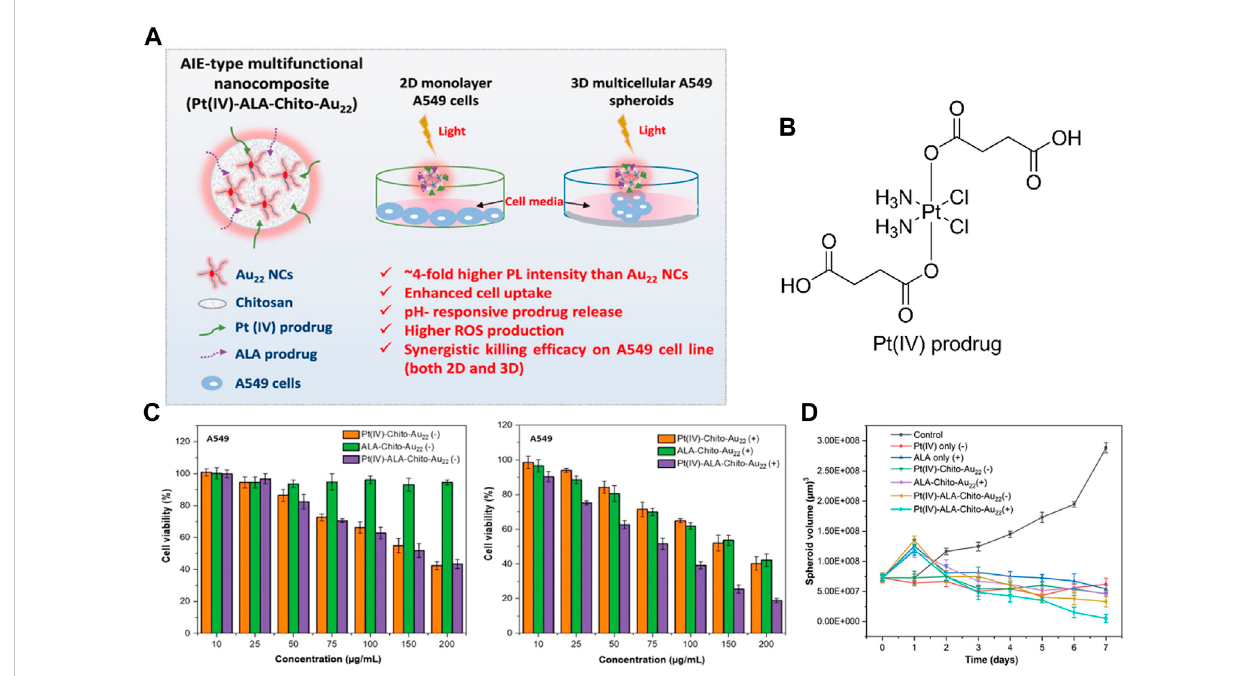
FIGURE 4 (A) Design of dual nanoprodrug Pt(IV)-ALA-Chito-Au 22 ; (B) Molecular structure of the Pt(IV) prodrug; (C) Cell viability of A549 cells after treatment